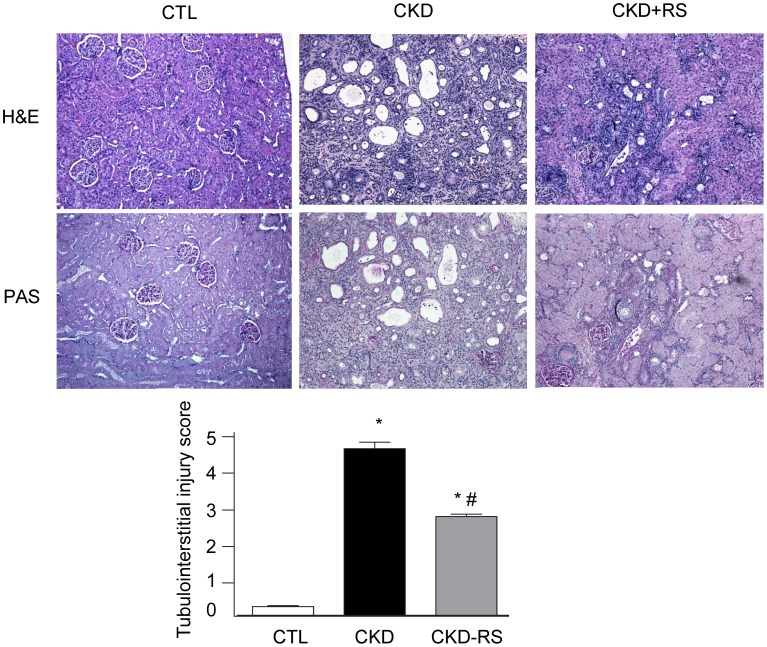
Representative photomicrographs of the PAS & H&E stained kidney sections in a normal control rat, a CKD rat fed low fiber, and a CKD rat fed high resistant starch diet [Magnification x10].The kidney tissue in the CKD animals exhibited significant tubulo-interstitial injury and fibrosis and heavy inflammatory cell infiltration which were significantly improved with high resistant starch diet (Upper panel). Bar graphs depicting tubulointerstitial injury scores in the study groups (Lower panel).